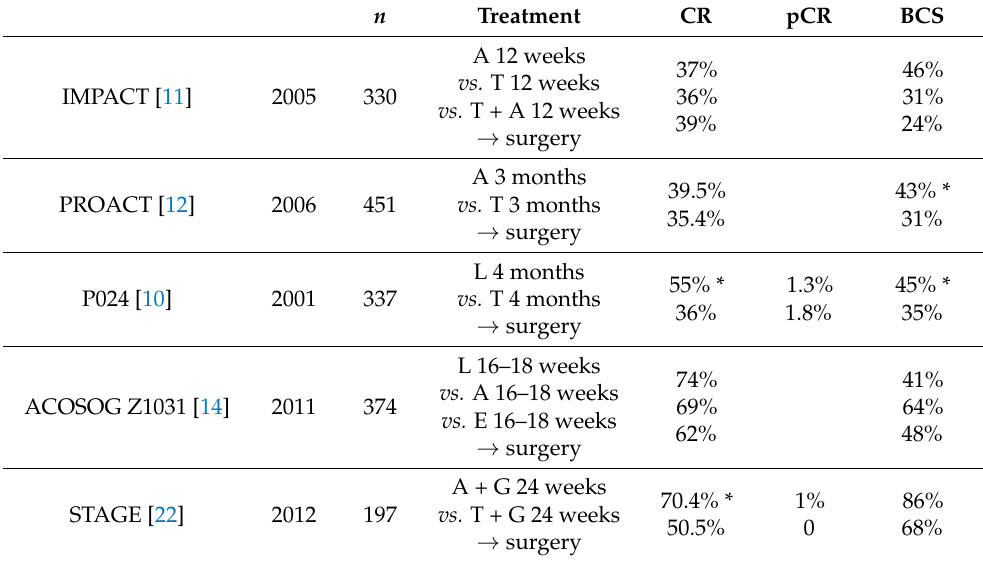
Table 1. Randomized trials comparing aromatase inhibitor (AI) vs. tamoxifen or AI vs. AI. * Signifi- cant ( p <